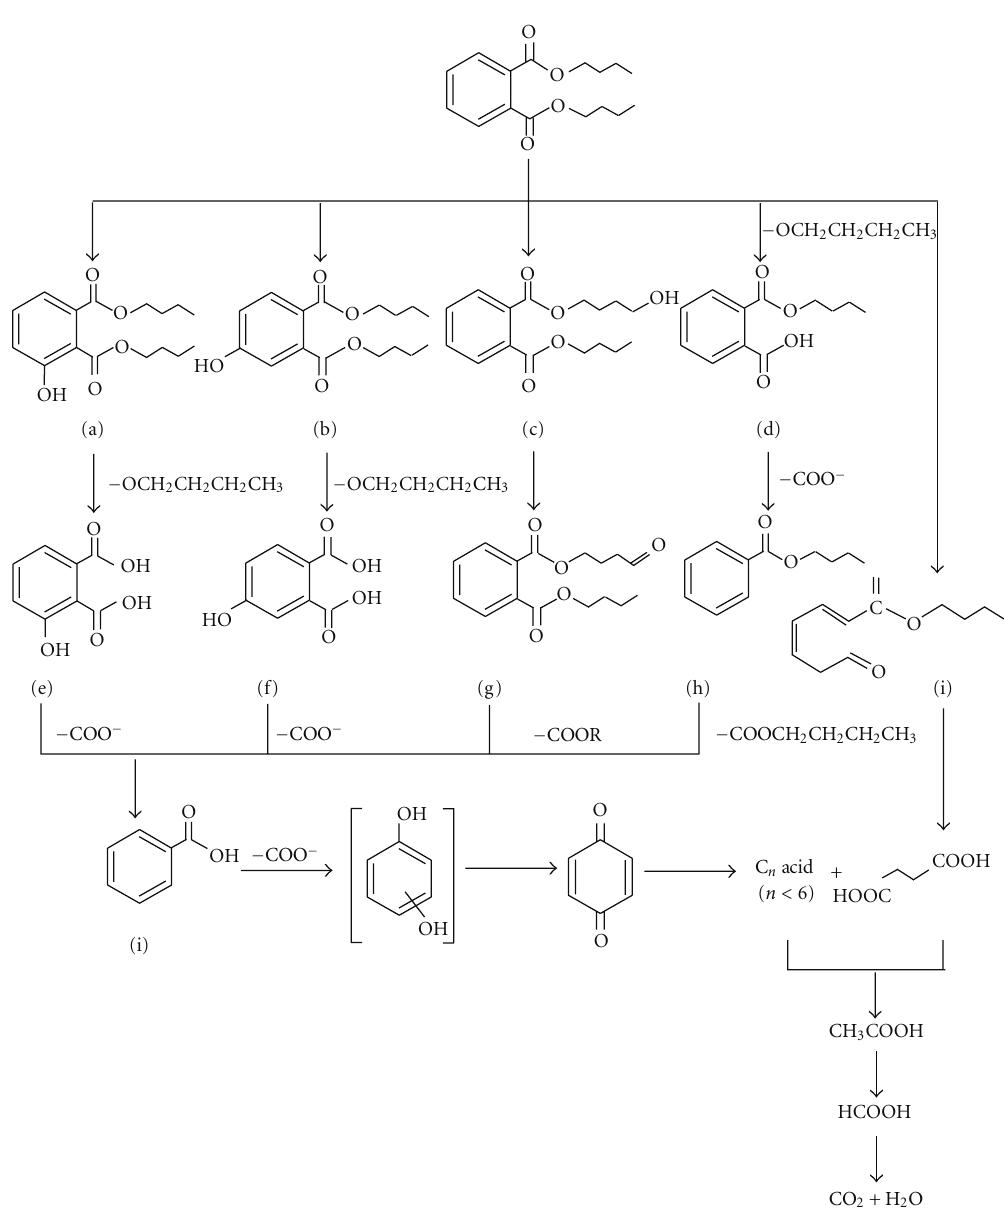
Figure 5: Photocatalytic degradation scheme for DBP